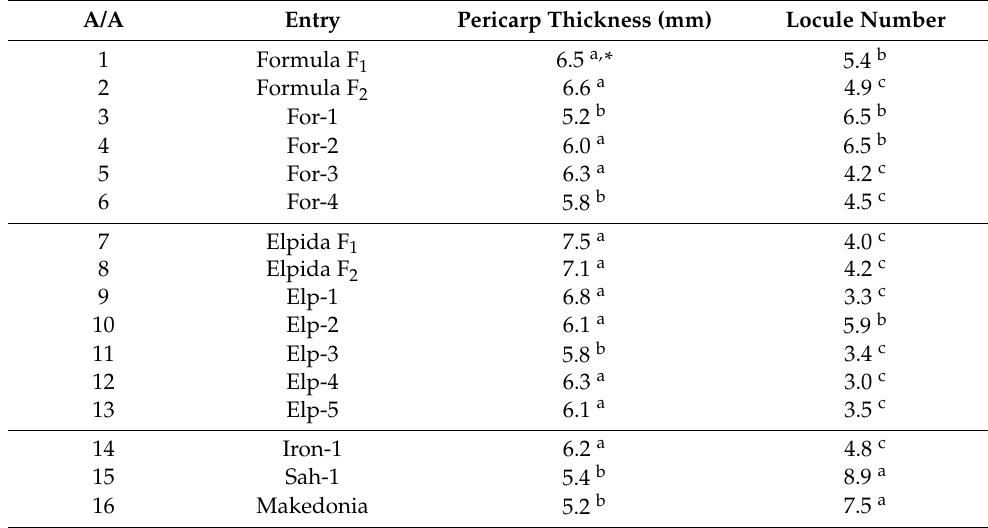
Table 3. Pericarp thickness (mm) and locule number of the original F1 commercial hybrids, new recombinant inbred lines, and the new reconstructed